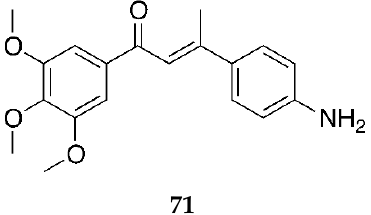
Figure 35. Chemical structures of 4′-aminochalcone derivative with methoxy substitutions on ring A.